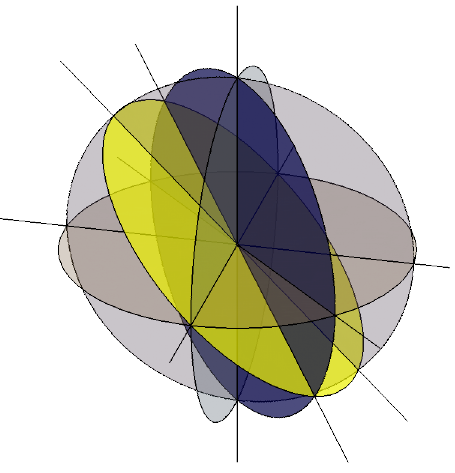
Figure 9. The scattering diagram associated with the asymptotic chambers of the A 2 , 2 cluster